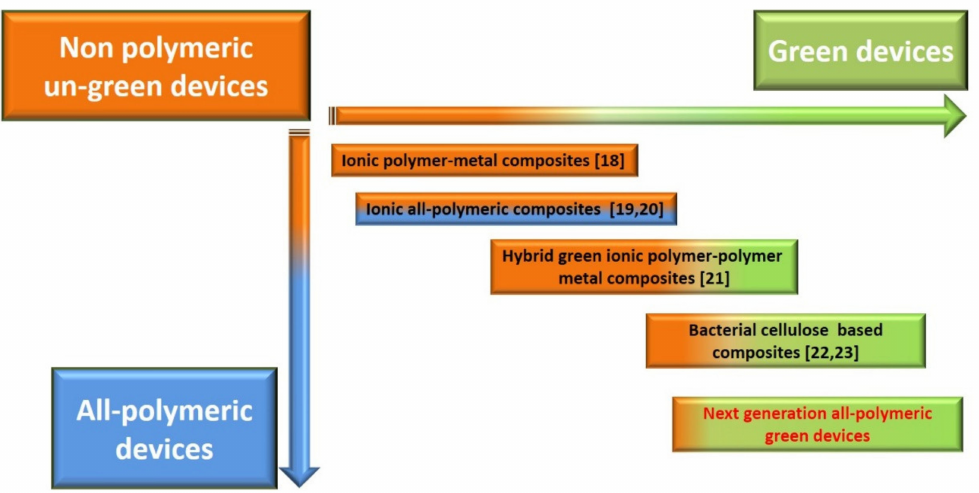
Figure 1. Scheme of the evolution that is occurring in the field of polymeric materials (numbers in brackets indicate papers reported in the References